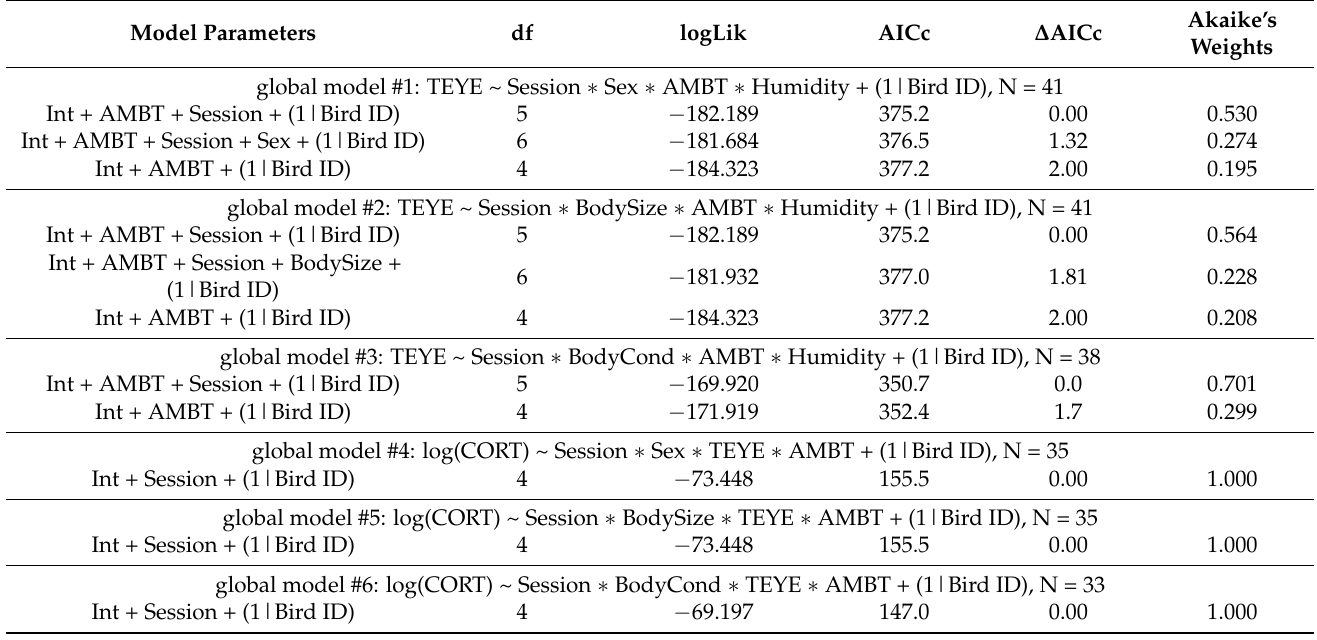
Table 1. Rank of the highest-ranked linear mixed models within global models estimating the effects of various predictors on maximal eye temperature (TEYE) and corticosterone level (CORT). AMBT—ambient air temperature, BodySize—total head length, BodyCond—scaled body mass,